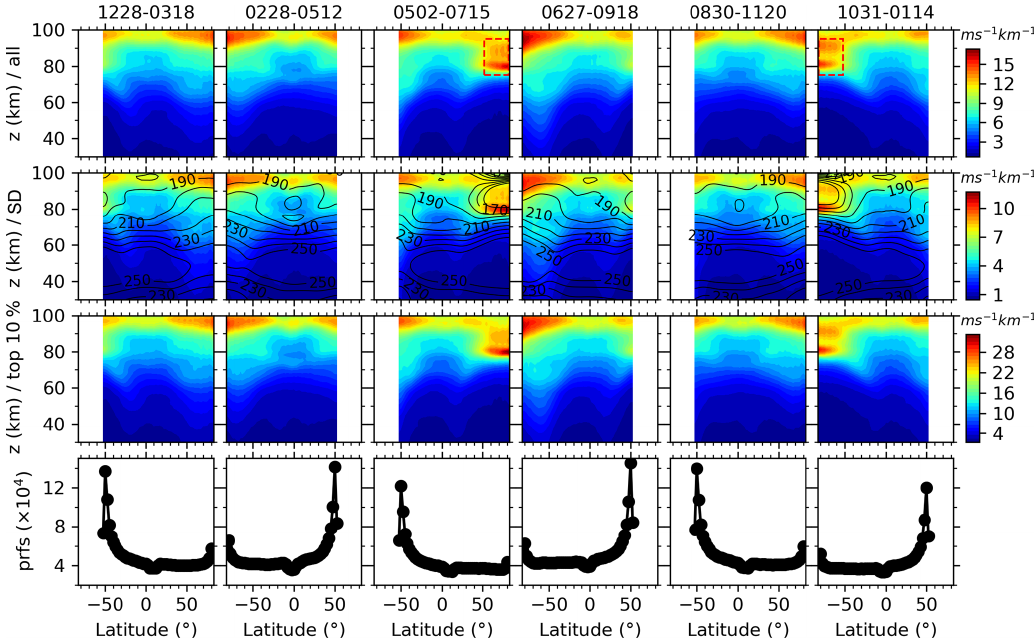
Figure 7. Same as Fig. 6 but during six composite yaw cycles from 2002 to 2019. The composite yaw cycle is the superposition of all the yaw cycles, which have nearly identical date coverage relative to the beginning of each calendar year, from 2002 to 2019. The date coverage of each yaw cycle is labeled on the top of each column (see text for detail). For more readability, the zonal-mean temperatures are shown as contour lines only in the second row. The rectangles are to highlight the peak at a lower height.